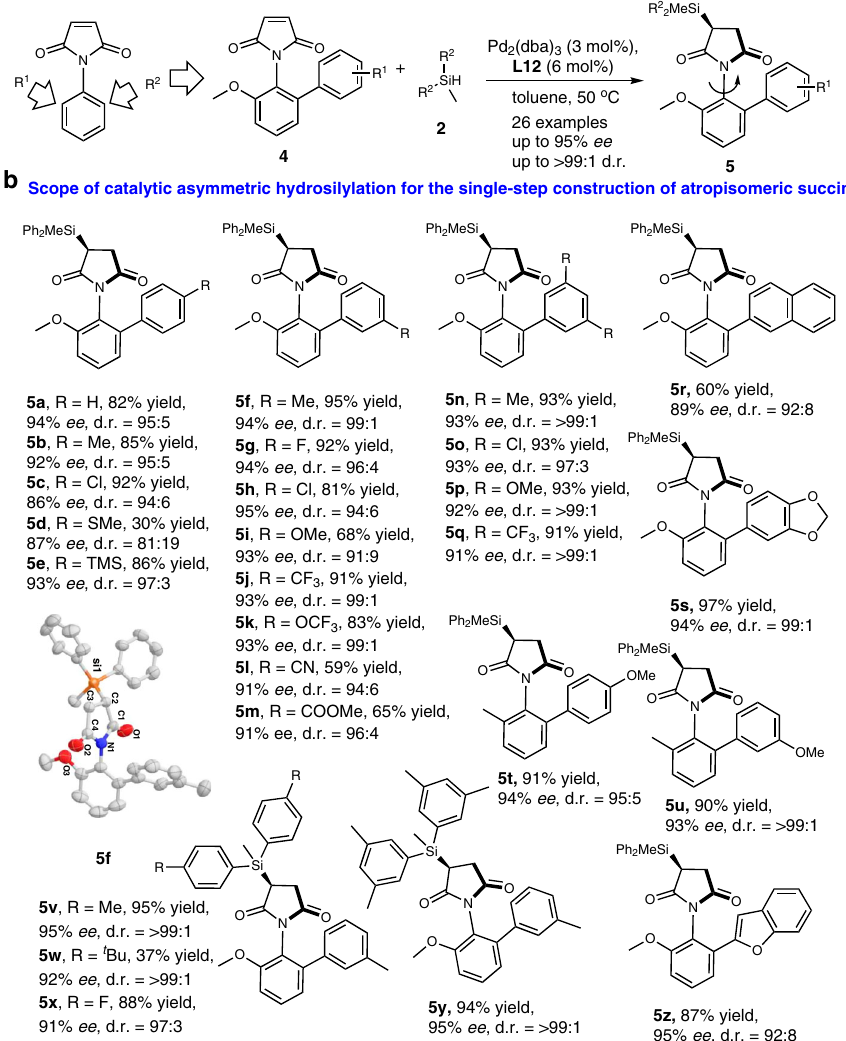
Fig. 3 Remote control of axial chirality of C – N bond by hydrosilylation. a The design of C – N bond rotatable atropisomers by introduction of two different substituents on the ortho -position of N -arylmaleimides to stabilise axial chirality. b The catalytic asymmetric hydrosilylation is broadly applicable in the construction of atropisomeric N -arylmaleimides with good chemo-, diastereo-, and enantioselectivity and in up to 97% yield. Products containing sp 3 central chirality and axial chirality can be accessed in the single step of Si – C coupling